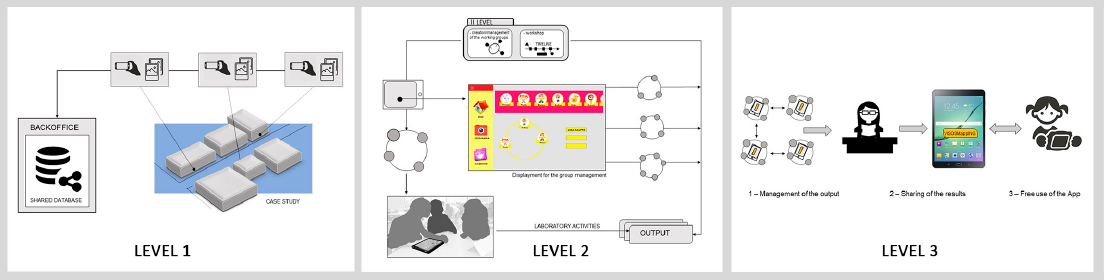
Figure 5. The app design by three